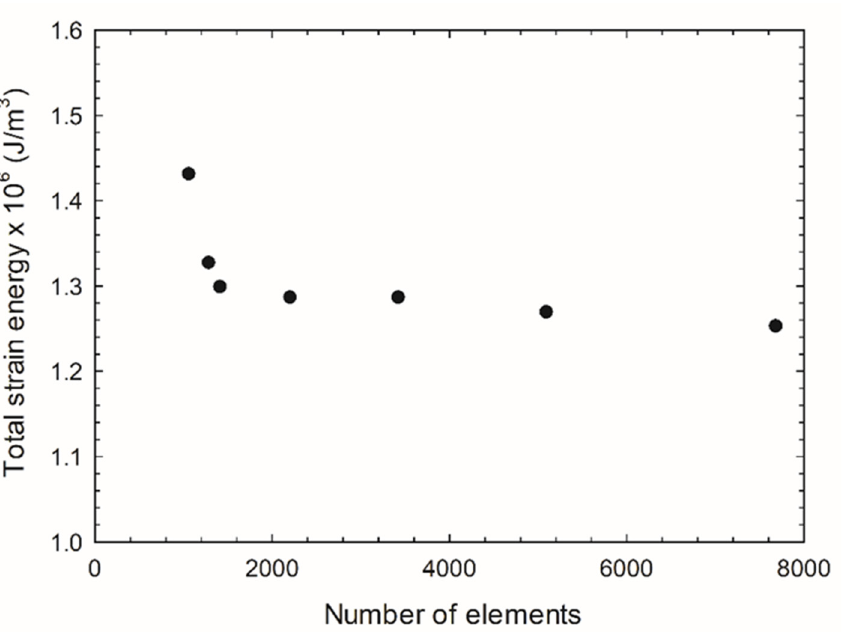
Figure 3. Convergence test for different numbers of elements.